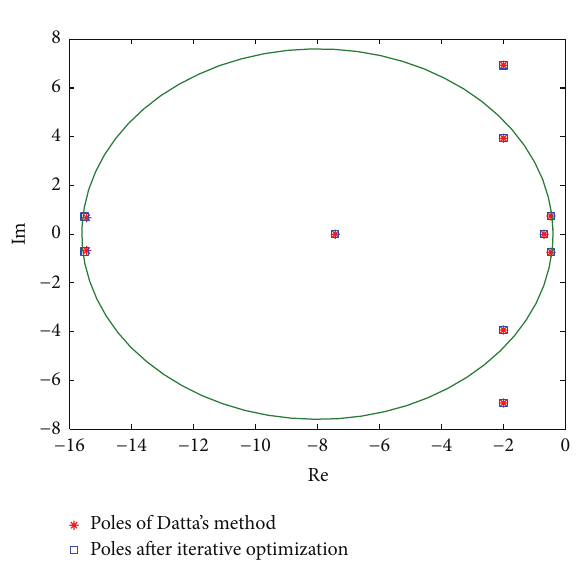
Figure 4: Closed loop poles of Example